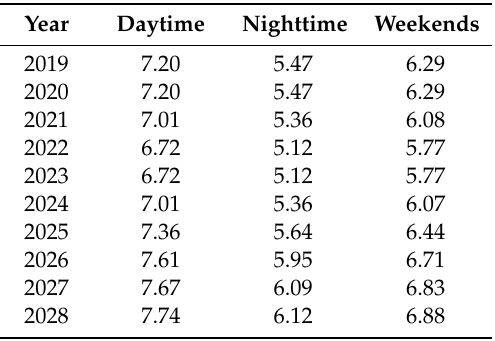
Table 6. System marginal price of coal generators, 2019–2028 (Unit: